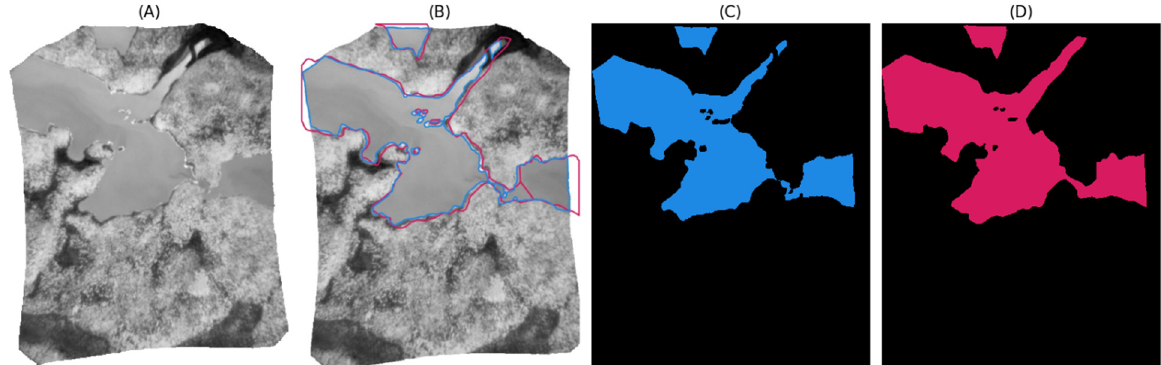
Figure 2. ( A ) Original raster image, with no-data values masked out for figure visibility; ( B ) original Raster with delineated waterbody boundary (blue) and existing CanVec boundary (pink) overlaid; ( C ) reference raster generated based on original raster and waterbody boundary; ( D ) Canvec Raster generated based on original raster image, adjusted to reflect no-data border in the original.